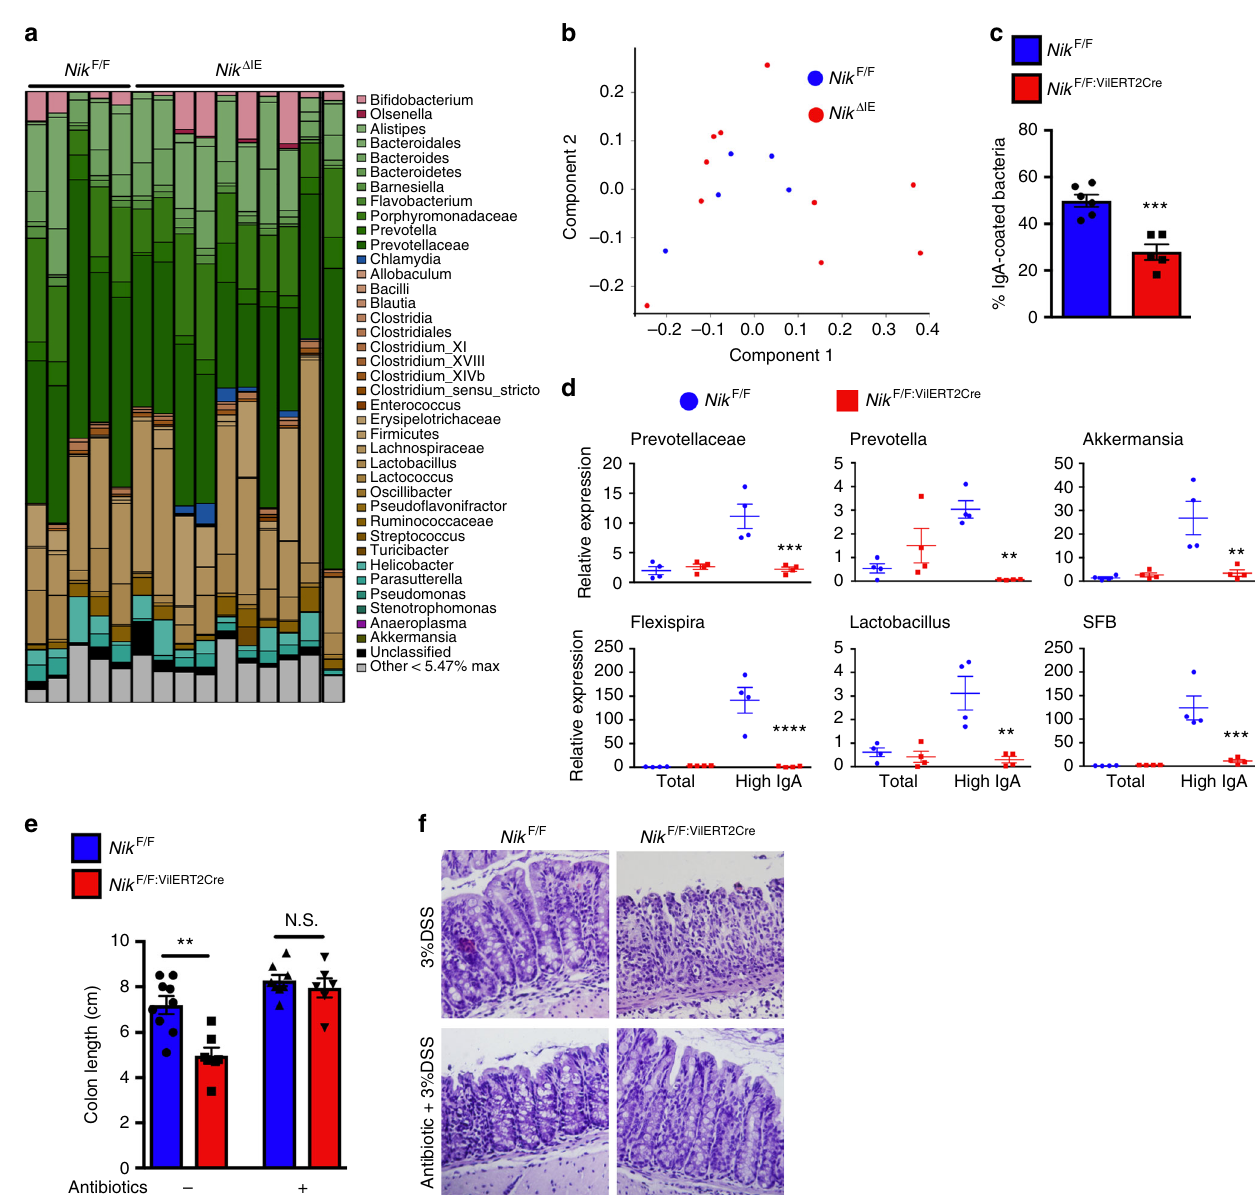
Fig. 6 Loss of epithelial NIK decreases IgA coating of colitogenic bacteria. a , b Bacterial composition ( a ) and PC2 plot ( b ) in the feces of 6-week-old Nik F/F and Nik Δ IE mice assessed by 16S genomic DNA sequencing. c Percentage of IgA-coated bacteria in the feces of Nik F/F;VilERT2Cre mice assessed by fl ow analysis. d qPCR analysis for bacterial DNA assessed in fl ow-sorted IgA-coated bacteria in the feces of Nik F/F;VilERT2Cre mice. Signi fi cance determined using t test. ** P < 0.01; *** P < 0.001; **** P < 0.0001. e , f Colon length ( e ) and H&E analysis ( f ) in DSS-treated Nik F/F;VilERT2Cre mice in the presence or absence of antibiotic cocktail. H&E images were taken at ×10 magni fi cation. Results are expressed as mean ± SEM. Signi fi cance determined using one-way ANOVA. ** P <